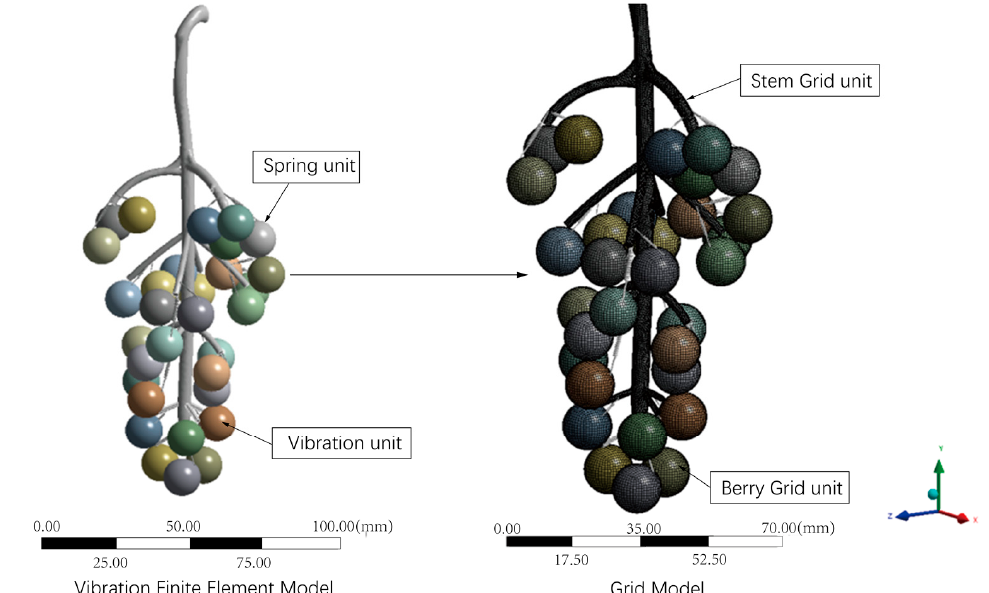
Figure 3. Grape finite element model. Table 2. Parameter settings, such as Poisson’s ratio.